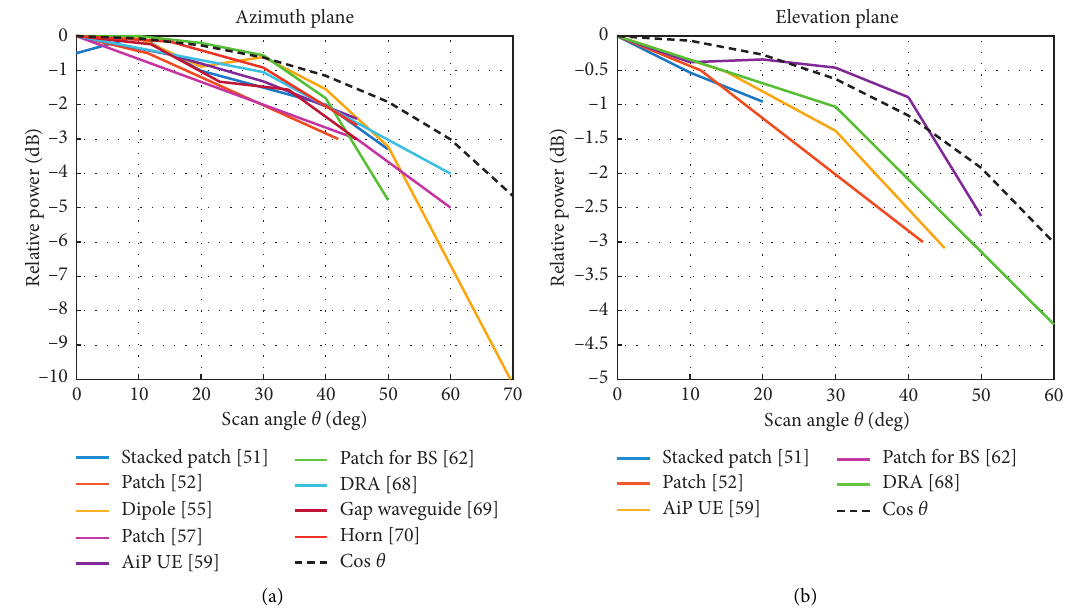
Figure 4: Scan loss of the most relevant antenna arrays along the azimuth plane (a) and the elevation plane (b).